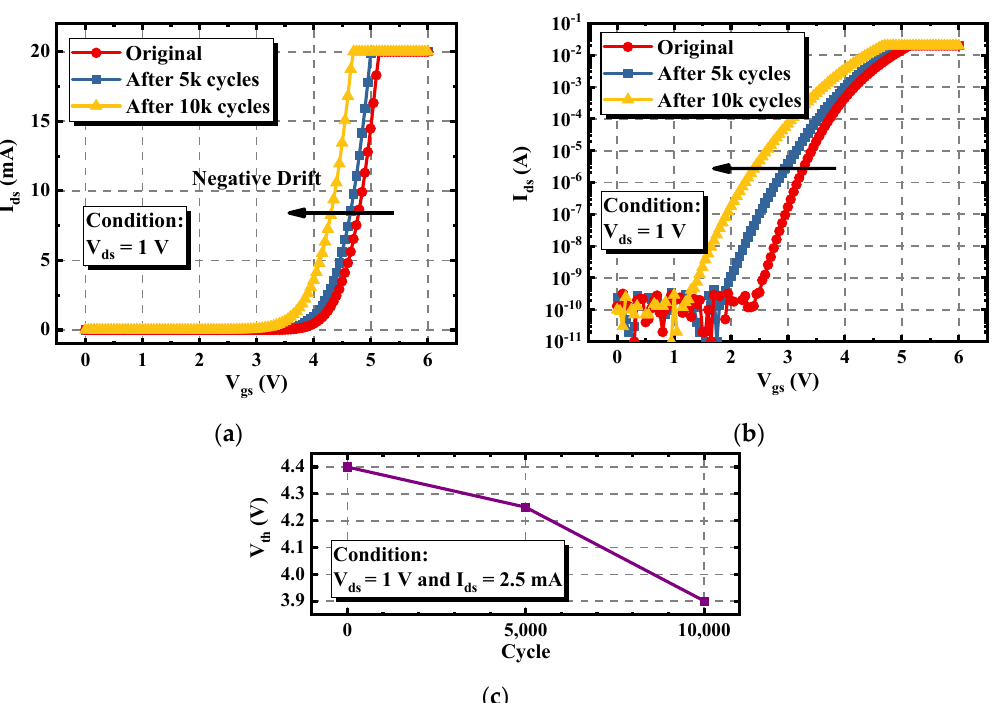
Figure 4. Variations of the I d -V g characteristic of the asymmetric trench SiC MOSFET under different avalanche stress cycles. ( a ) I d -V g curves in the linear scale. ( b ) I d -V g curves in the logarithmic scale. ( c ) Extracted degraded V th . The variations of the I d -V d characteristics of the asymmetric trench device under the conditions of V gs = 6 V and V gs = 18 V are plotted in Figure 5a,b. The I ds under the condition of V gs = 6 V increased due to the decrease of the V th . Meanwhile, the I d -V d curve remained stable when the device was biased under the condition of V gs = 18 V.